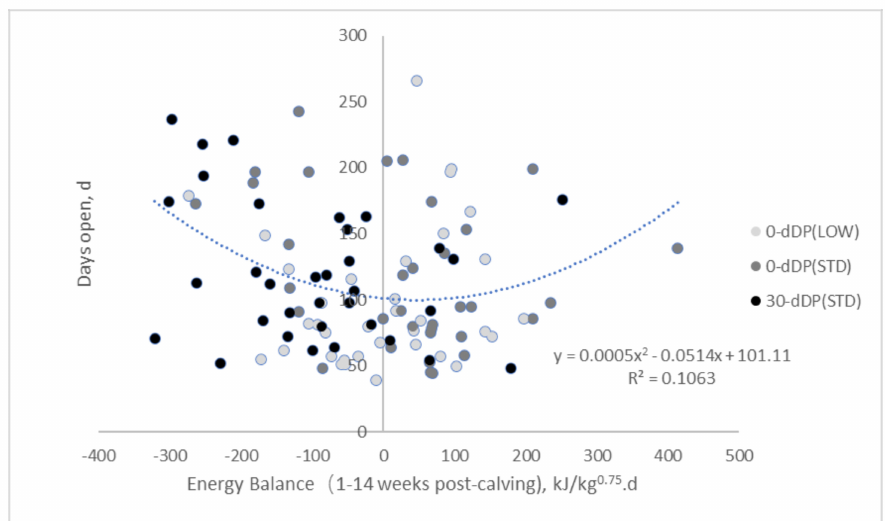
Figure 3. Energy balance for cows with di ff erent transition treatments in 1–14 weeks post-calving. Transition treatments were: 0-d dry fed low energy level postpartum (0-d (LOW)); 0-d dry fed a standard energy level postpartum (0-d (STD)); 30-d dry fed a standard energy level postpartum (30-d